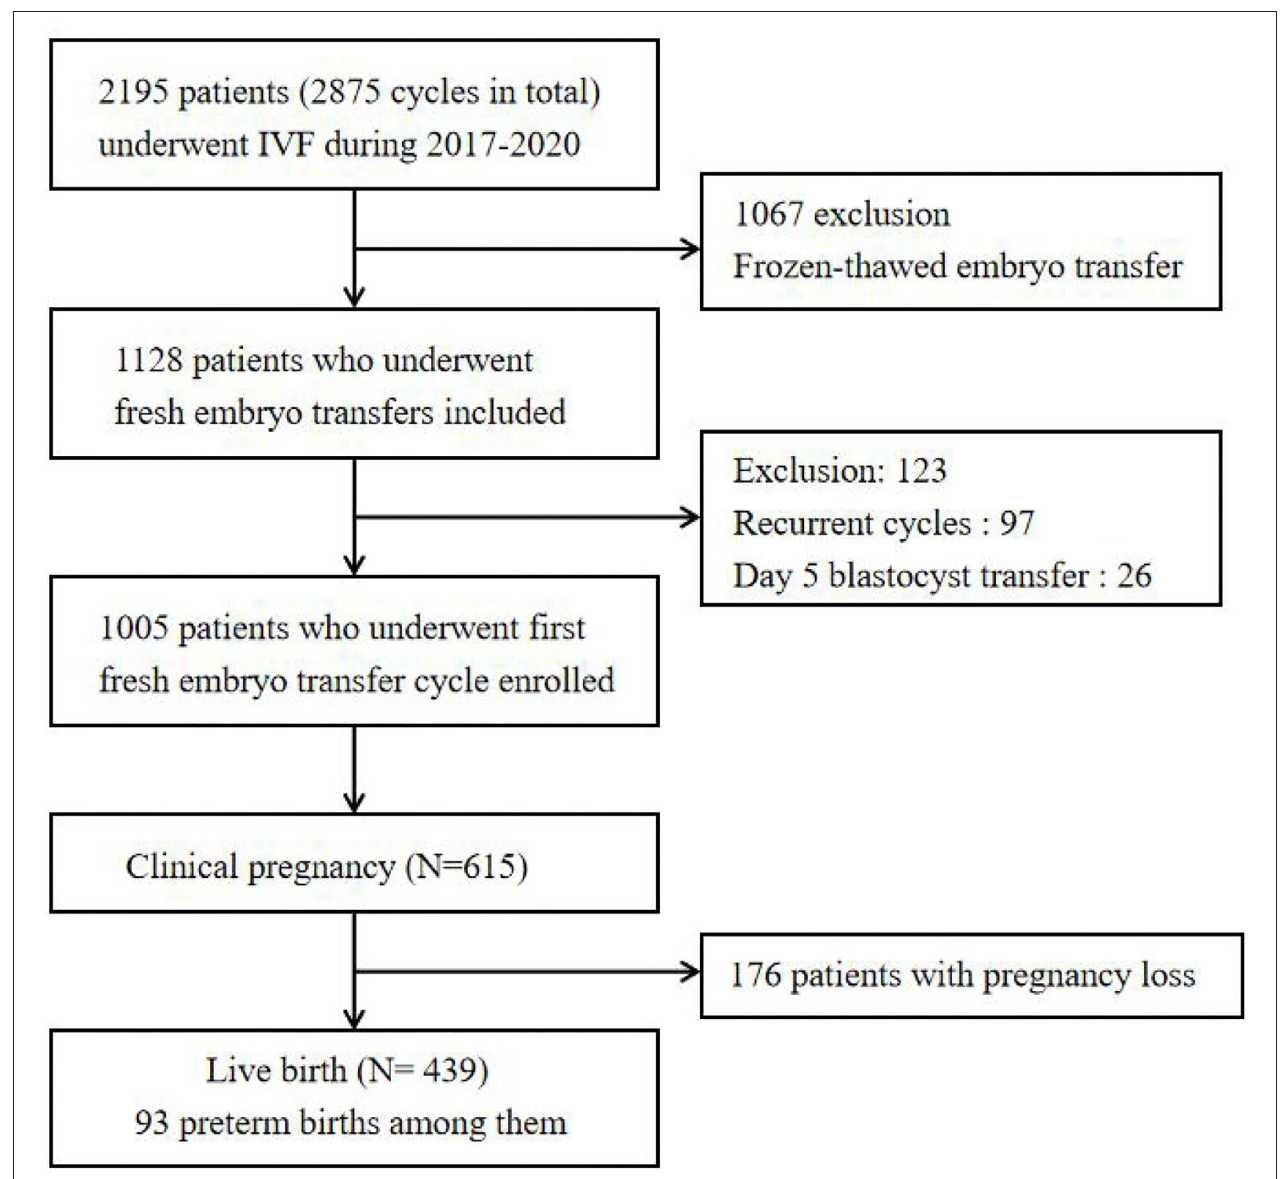
FIGURE 1 | The flowchart of the participants